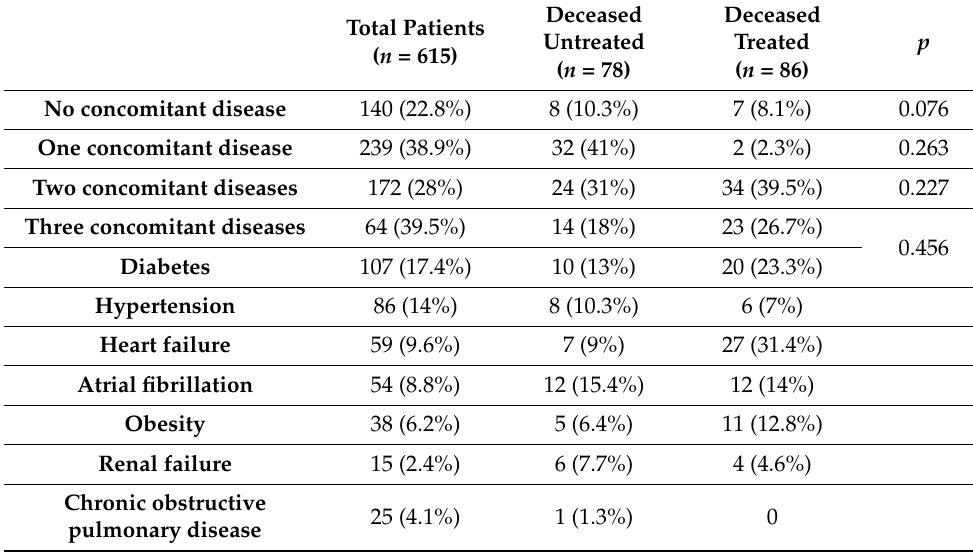
Table 2. Comorbid diseases in study sample.